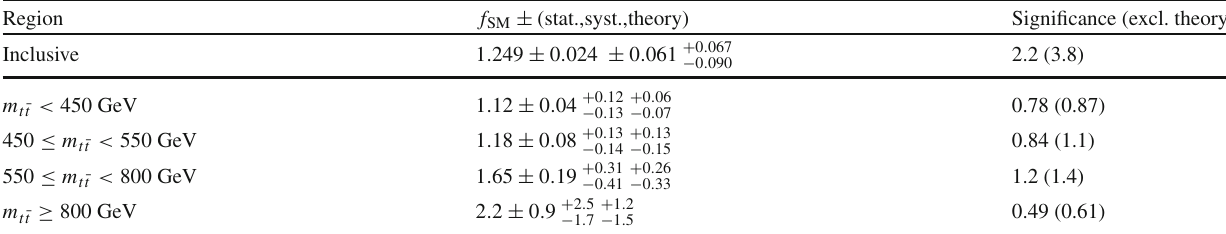
of scale variations and PDF uncertainties, as well as the uncertainty arising from including top quark decays via MadSpin in the nominal t ¯ t MC. The values in brackets exclude the effect of theoretical uncer- tainties on the hypothesis templates and only include the statistical and systematic uncertainties on the data